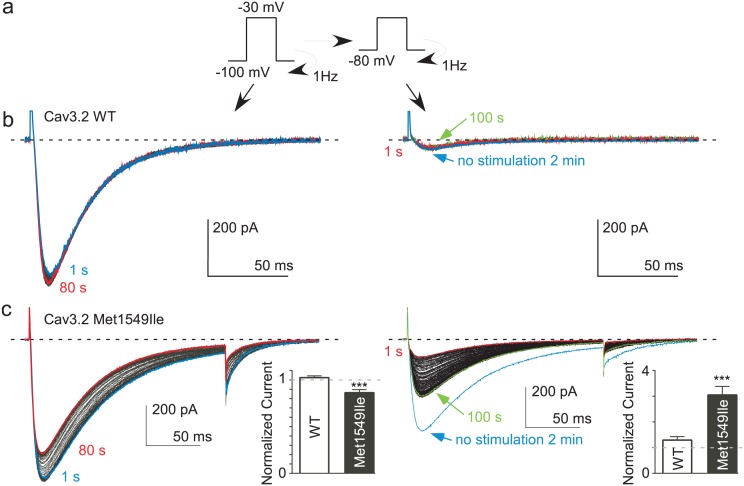
Modulation of the Cav3.2 Met1549Ile mutant channel at a high frequency of stimulation.Similar to that described for Figure 5, the Cav3.2 current recovery was measured at a HP of −80 mV (a–b, right panels) after their inhibition by 1 Hz stimulation at a HP of −100 mV (a-b, left panels) for wild-type (WT) Cav3.2 channels (b) and for the Cav3.2 Met1549Ile channels (c). The average current decrease at HP −100 mV and the average current increase at HP −80 mV are shown in (c) as insets in the left and the right panels, respectively (n = 23–31).